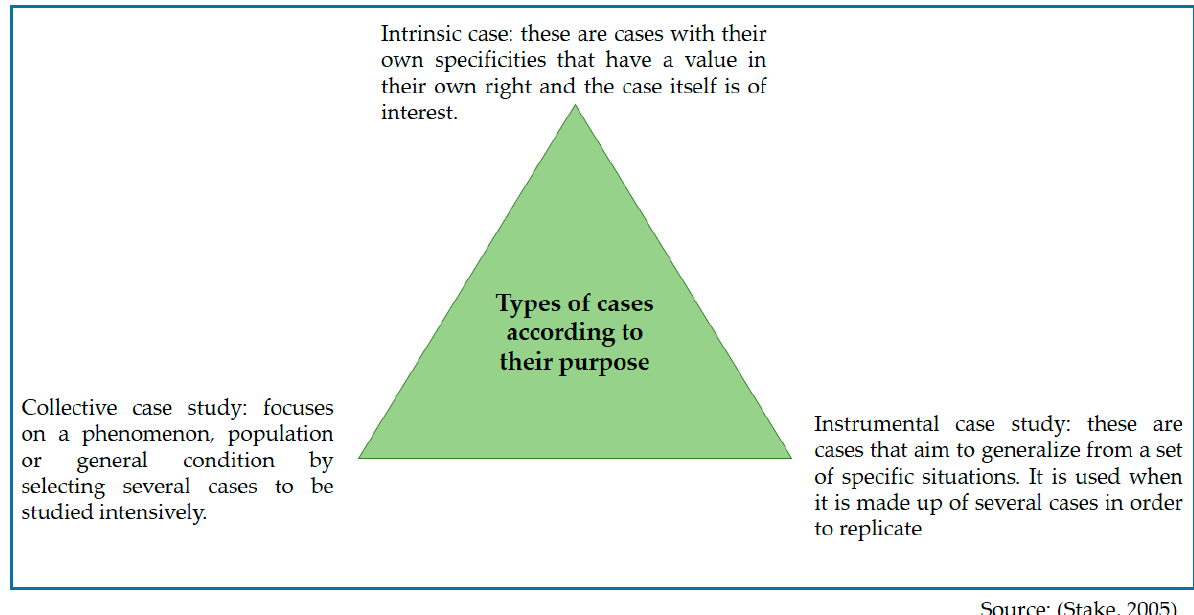
Figure 3. Types of cases according to their purpose [32].